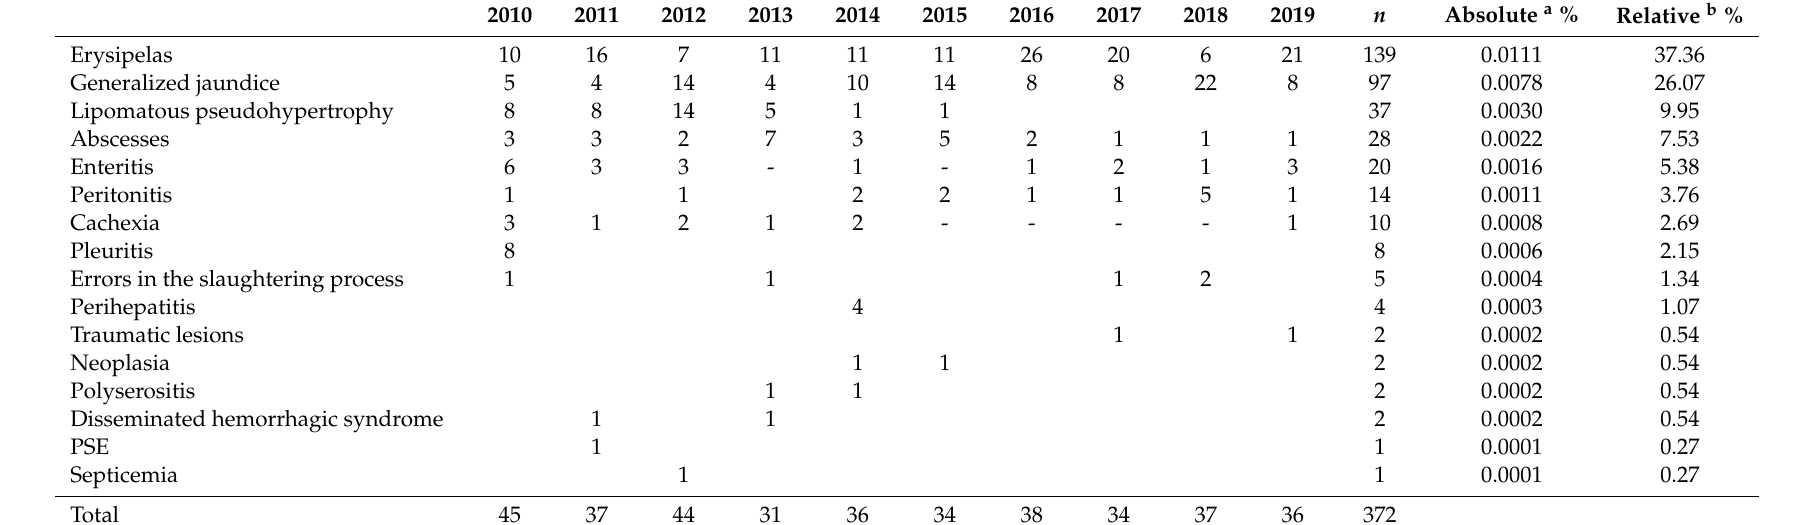
Table 2. Details of the frequency and causes of whole carcass condemnations. PSE: pale soft